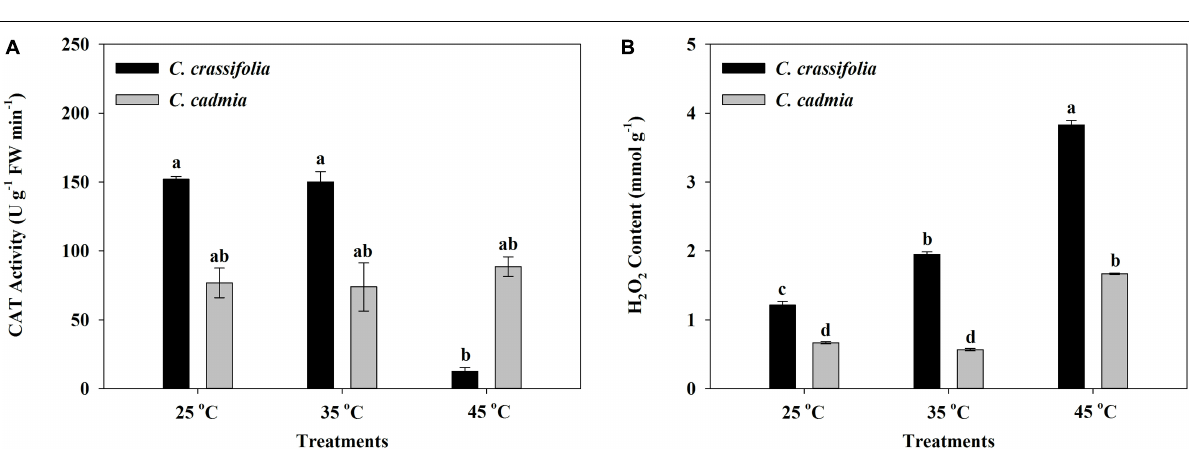
FIGURE 4 | Effect of heat stress on the peroxidase (POD) activity and the superoxide dismutase (SOD) activity of C. crassifolia and C. cadmia grown under three different temperatures. (A) POD activity. (B) SOD activity. Error bars indicate SE ( n = 5 plants). Different letters indicate significant differences based on two-way ANOVA followed by Tukey multiple comparisons ( P ≤ 0.05).